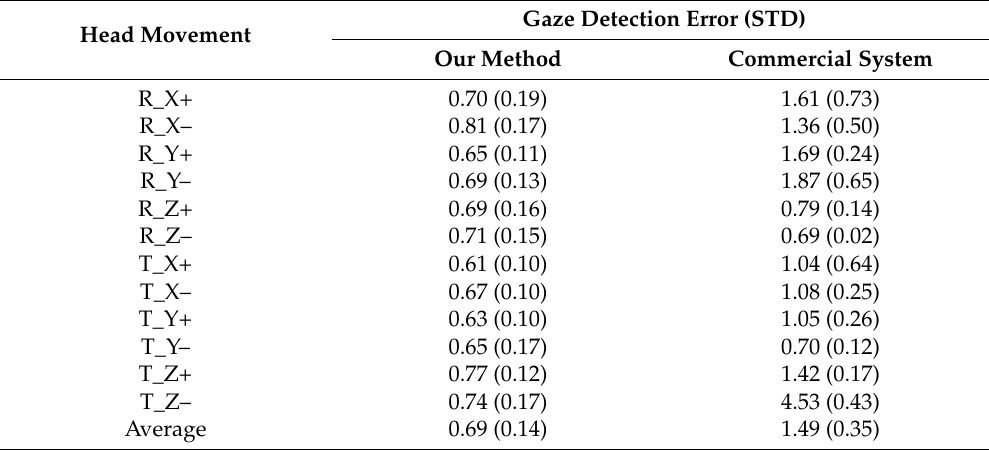
Table 6. Comparisons of gaze detection errors with commercial system (TheEyeTribe) (unit: %).